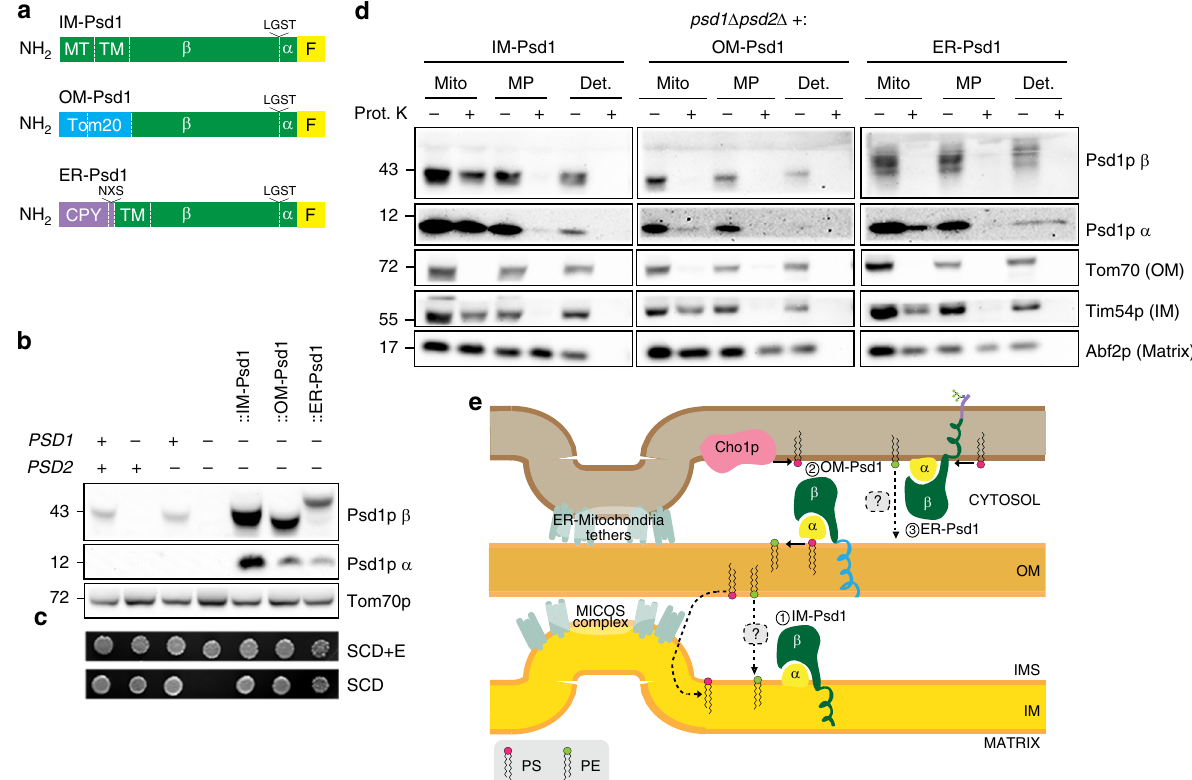
Fig. 2 OM-Psd1 and ER-Psd1 constructs are functional and properly mis-localized. a Schematic of IM-Psd1, OM-Psd1, and ER-Psd1. All three constructs contain a 3XFLAG tag at the C-terminus (F, yellow). The Tom20 residues (1 – 100) that replace the mitochondrial targeting sequence (MT) and transmembrane (TM) domain of IM-Psd1 (green) are shown for OM-Psd1 (blue), and the carboxypeptidase Y signal sequence (residues 1 – 37) as well as an NXS motif are indicated for ER-Psd1 (purple). b The β and α subunits of Psd1 were detected in yeast whole cell extracts of the indicated strains by immunoblot. Tom70 served as a loading control. c The indicated strains were spotted onto synthetic complete dextrose (SCD) medium with or without ( + / − ) 2 mM ethanolamine ( + E) and incubated at 30 °C for 4 days. d Protease protection assay in intact mitochondria (Mito), osmotically ruptured mitochondria (MP), or deoxycholate-solubilized mitochondria (Det.). Following incubation without or with ( − / + ) 100 μ g proteinase K (Prot. K) for 30 min, samples were collected, resolved by SDS-PAGE and immunoblotted for Psd1p ( β and α subunits), and the mitochondrial compartment-speci fi c markers Tom70 (OM), Tim54 (IM), and Abf2 (matrix). e Illustration indicating the topology of (1) IM-Psd1, (2) OM-Psd1, and (3)